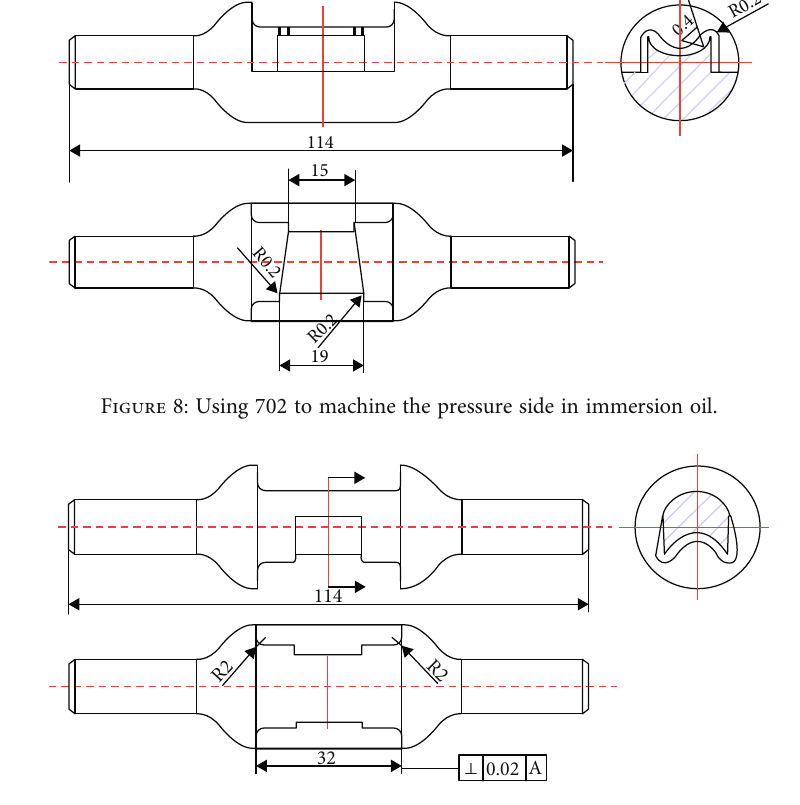
Figure 9: Using to machine the transition segments in immersion